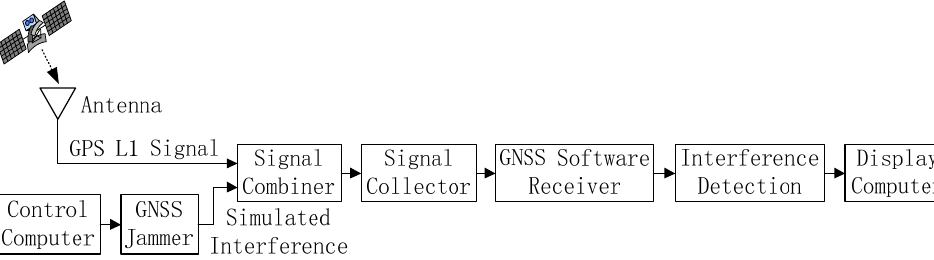
Figure 7. The scheme of the GNSS interference detection experiment.